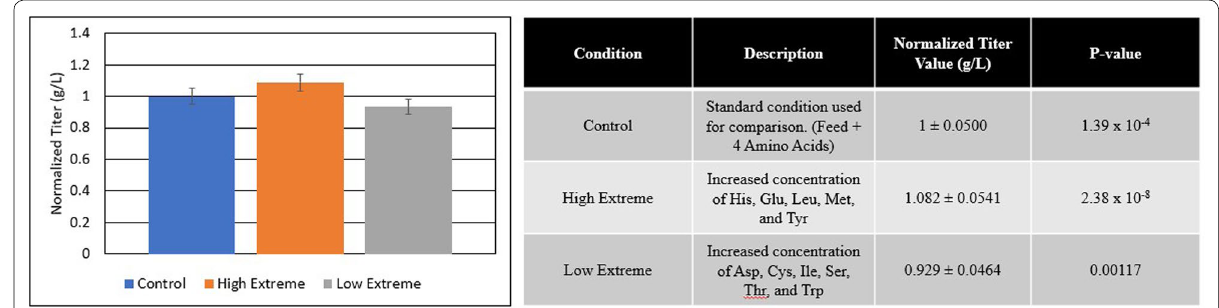
Fig. 6 Validation results: The validation experiment demonstrated that the “high extreme” and “low extreme” conditions were able to provide a relative increase or decrease (respectively) in titer. The control condition that was used includes the four additional amino acids that were previously identified. Thus, an overall increase in titer can be observed based upon a previously optimized feeding